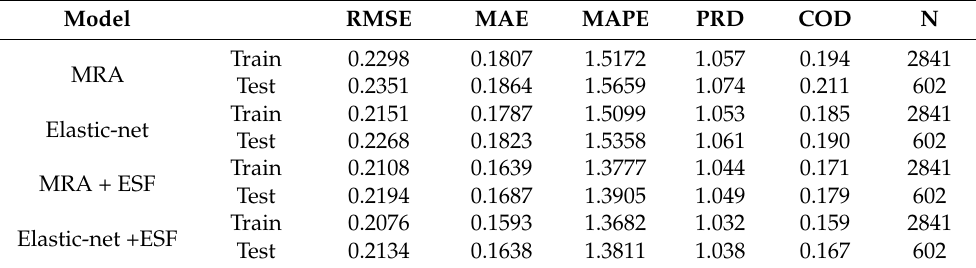
Table 4. Model prediction accuracy and ratio